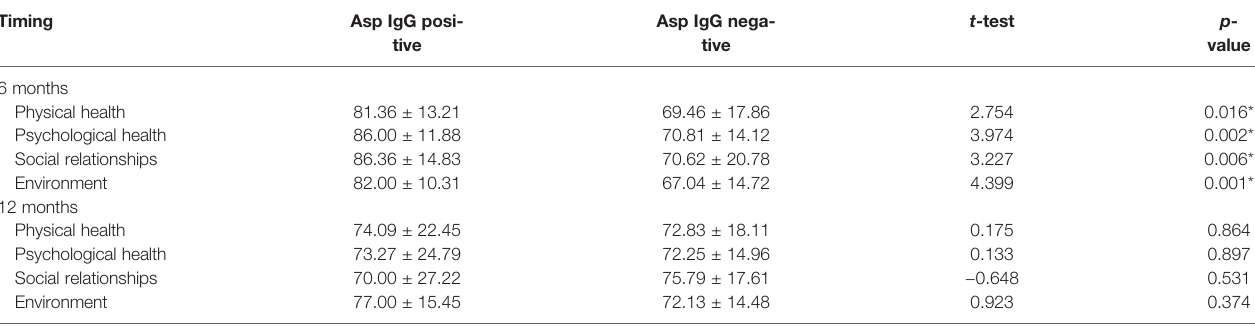
TABLE 4 | Mean HRQoL scores in Asp IgG +ve and Asp IgG +ve